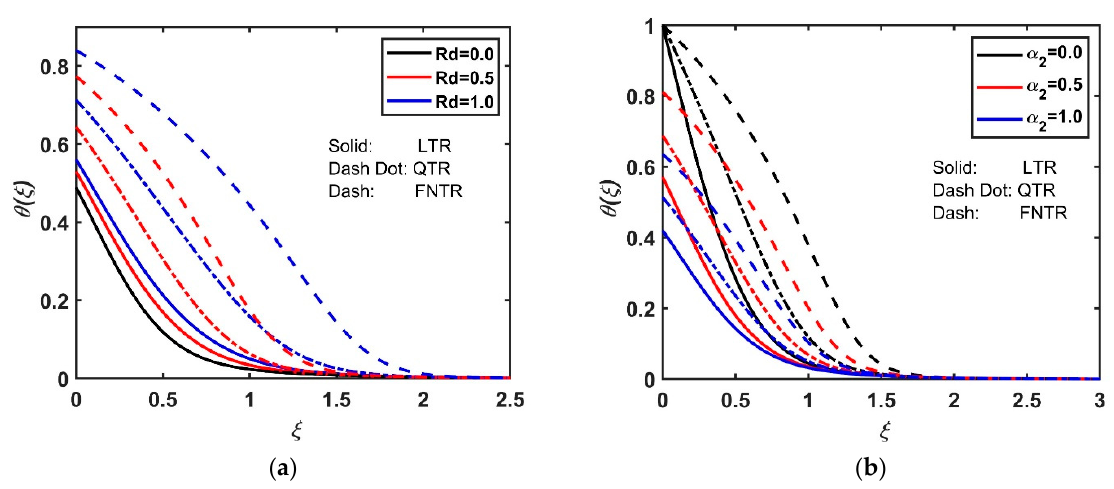
Figure 4. Impact of ( a ) 𝑅𝑑 on 𝜃(𝜉) , and ( b ) 𝛼 (cid:2870) on 𝜃(𝜉) for LTR, QTR and FNTR